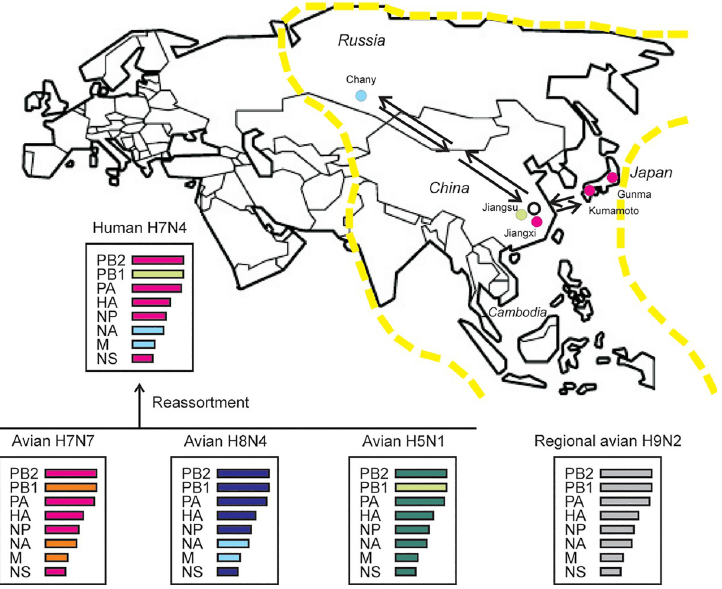
Fig 3. Probable multi-reassortment of the novel human H7N4 virus. For JS2018, the PB2, PA, HA, NP, and NS segments (magenta) were avian H7N7-derived; The NA and M segments (cyan) were donated by an avian H8N4 virus; PB1 (green) was likely obtained from an avian H5N1 virus. Remarkably, none of these internal segments was acquired from any known regional H9N2 viruses (grey). Possible migratory route of birds carrying H7N7 or H8N4 viruses was shown in arrows in the map. Magenta dot: Gunma (Japan), Kumamoto (Japan), Jiangxi (China). Cyan dot: Chany (Russia). Green dot: Changzhou, Jiangsu (China). Yellow dashline: the East Asia-Australia migratory flyway. https://doi.org/10.1371/journal.pone.0227597.g003 chickens) and Dk2018 (from ducks) isolated from the source farm, as well as other avian H7N4 isolates. The data were further compared with the sequences and mutations identified in human H7N9 and H5N1 isolates, which led to human infection in the same geographic region in China, in order to identify mutations in AIVs critical for human adaptation. Table 1. Molecular features of the human and related domestic avian H7N4 isolates compared to human H7N9 and H5N1 strains.